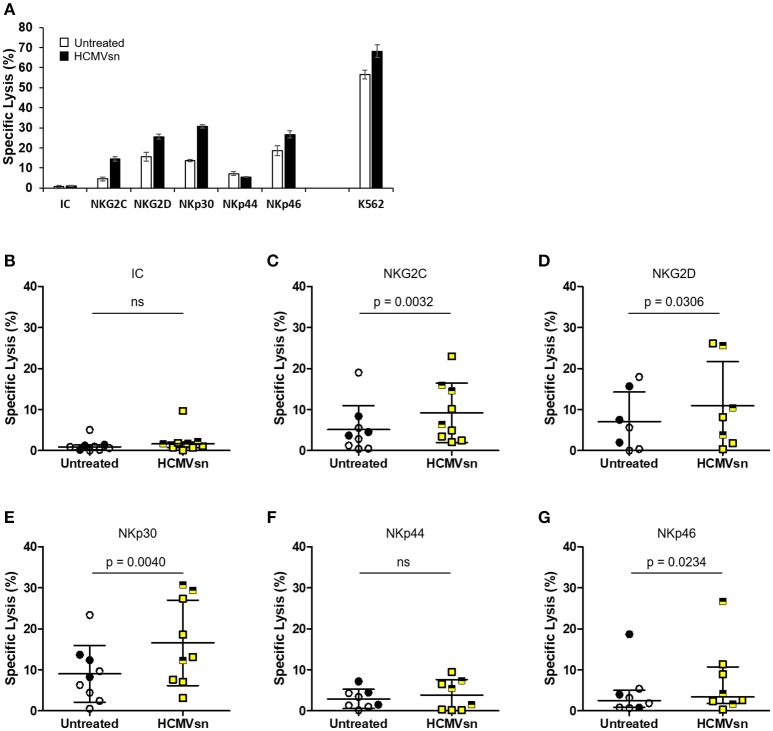
Effect of HCMVsn on NK cell cytotoxicity directed through different receptors. (A) Natural cytotoxicity (K562 cells), and redirected lysis of P815 cells in the presence of NK receptor-specific mAb for a representative subject with or without HCMVsn was measured over 5 h. Error bars represent mean ± standard error of the mean with three replicates. Redirected P815 cell lysis was measured at E:T 30:1 with 3 μg/mL (B) isotype control (IC), (C) anti-NKG2C, (D) anti-NKG2D, (E) anti-NKp30, (F) anti-NKp44, or (G) anti-NKp46 mAbs. Assays represented in plots (B–G) were performed in triplicate for 7–9 individuals. Subjects seropositive for HCMV are represented with filled black circles or yellow squares half-shaded black. Error bars for isotype control and anti-NKp46 plots represent median with IQR and the probability of a difference between conditions was assessed by Wilcoxon signed-rank test. All other bars represent mean ± SD with comparison between conditions by Student's paired t-test.